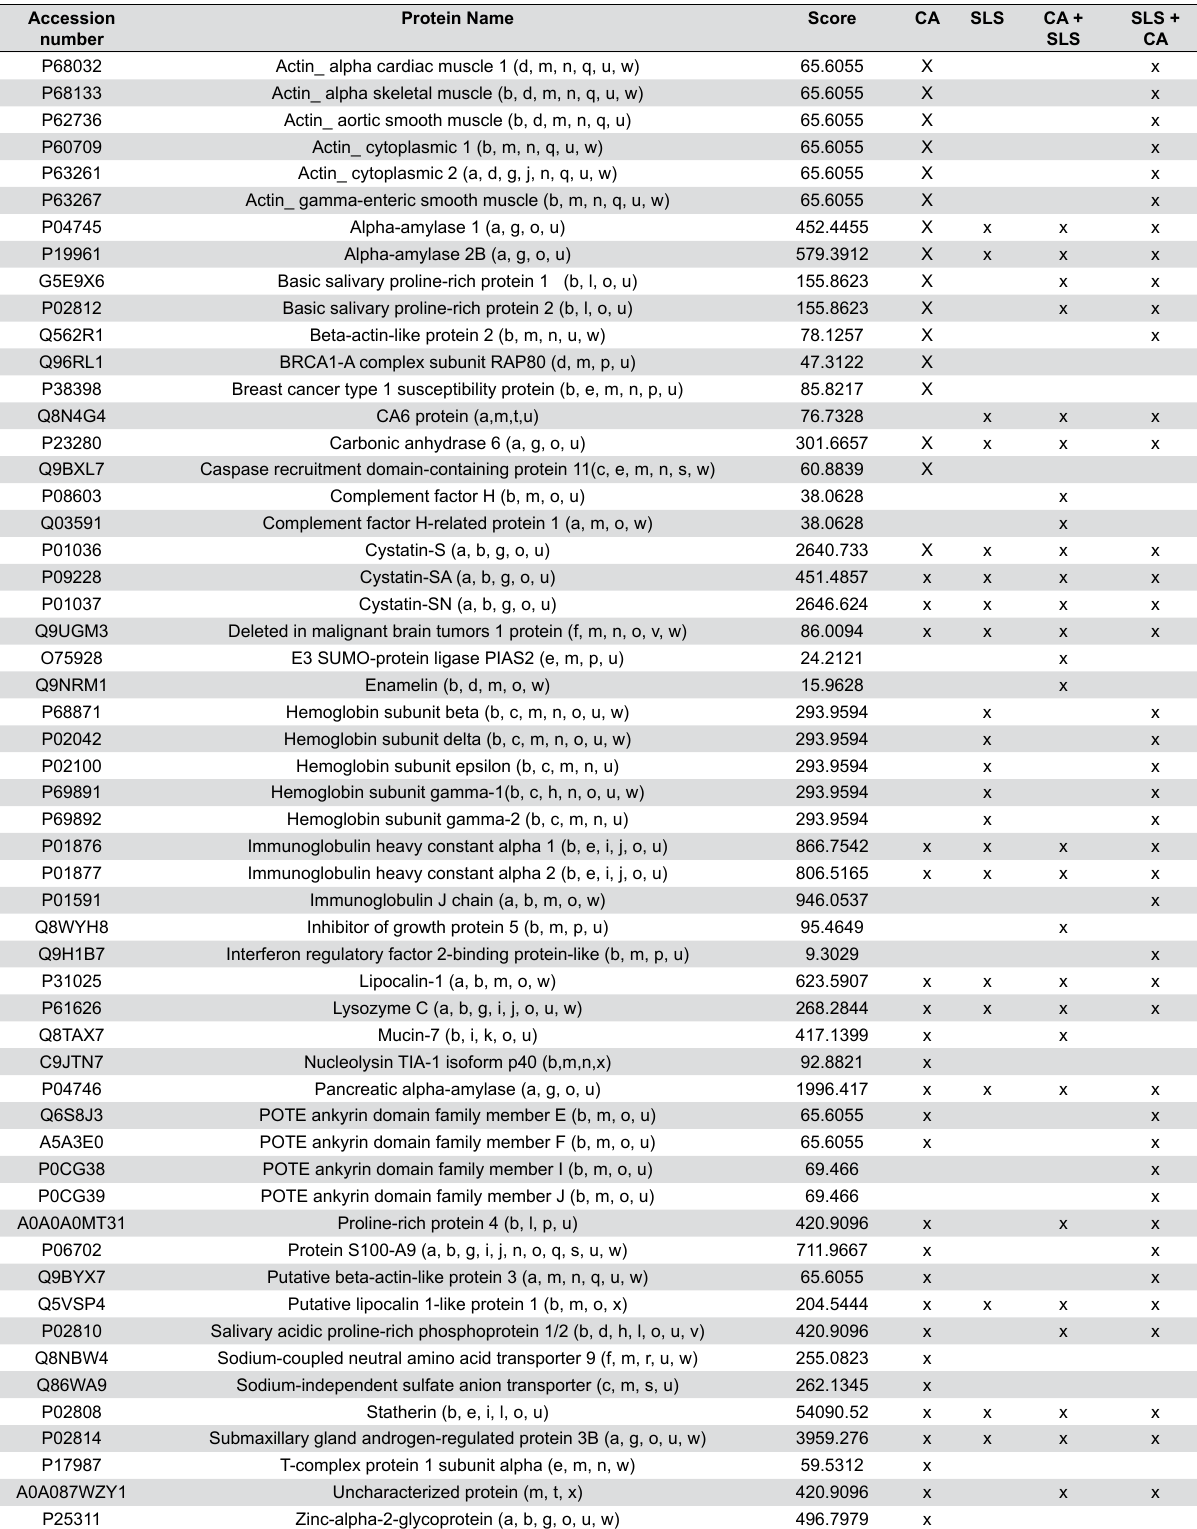
Table S1- Classification of proteins from the acquired pellicle collected in vitro represented in each